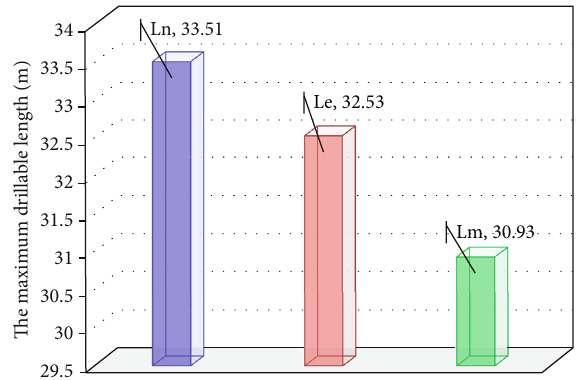
Figure 12: Comparison of simulation, calculation, and experiment results of the maximum drillable